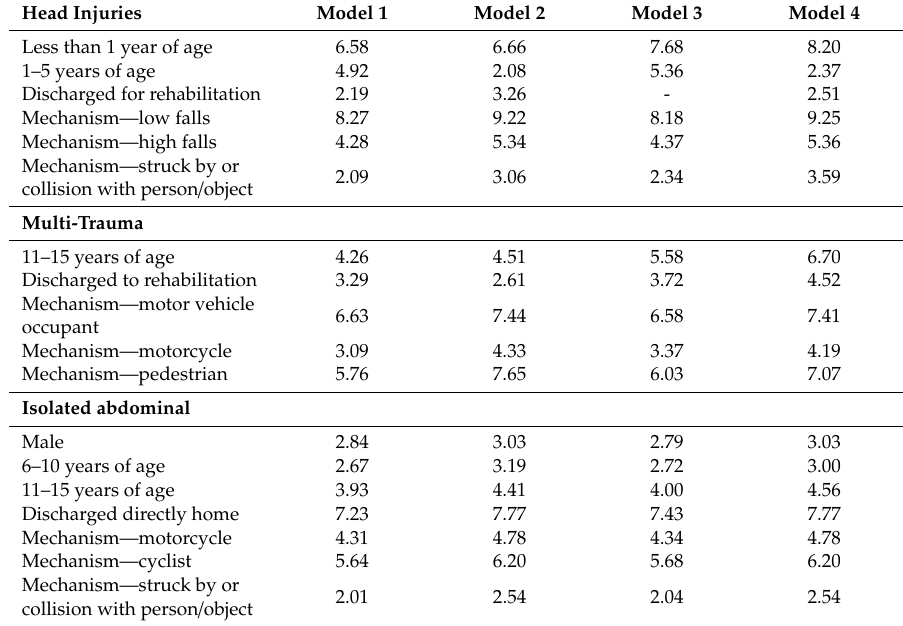
Table 3. Significant Adjusted Residuals (AR) for key characteristics across final latent